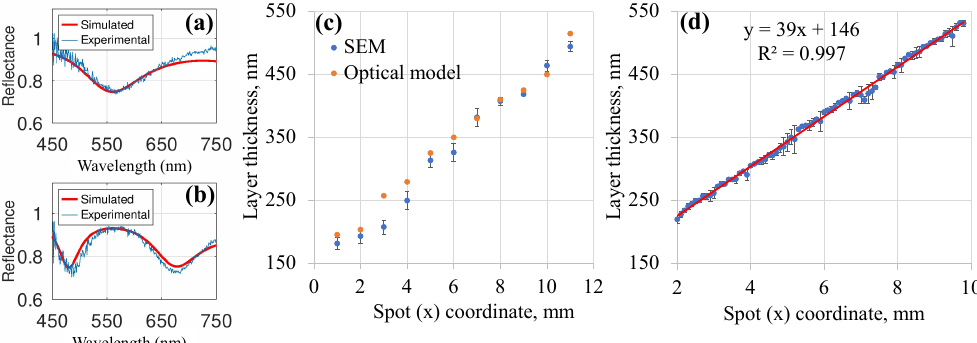
Figure 3. ( a , b ) Measured and calculated reflectance spectra at different layer thicknesses, 260 and 520 nm, of ZnO NR–PAAO hybrid film on Al substrate. ( c ) Comparison of hybrid film thickness measurements at different sample positions (x coordinate) obtained by SEM and fitting the reflectance spectra (optical model). ( d ) Hybrid film thickness profile obtained using reflectance measurements.